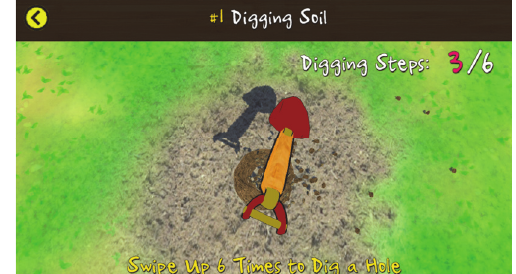
Figure 14: Digging-soil scene.